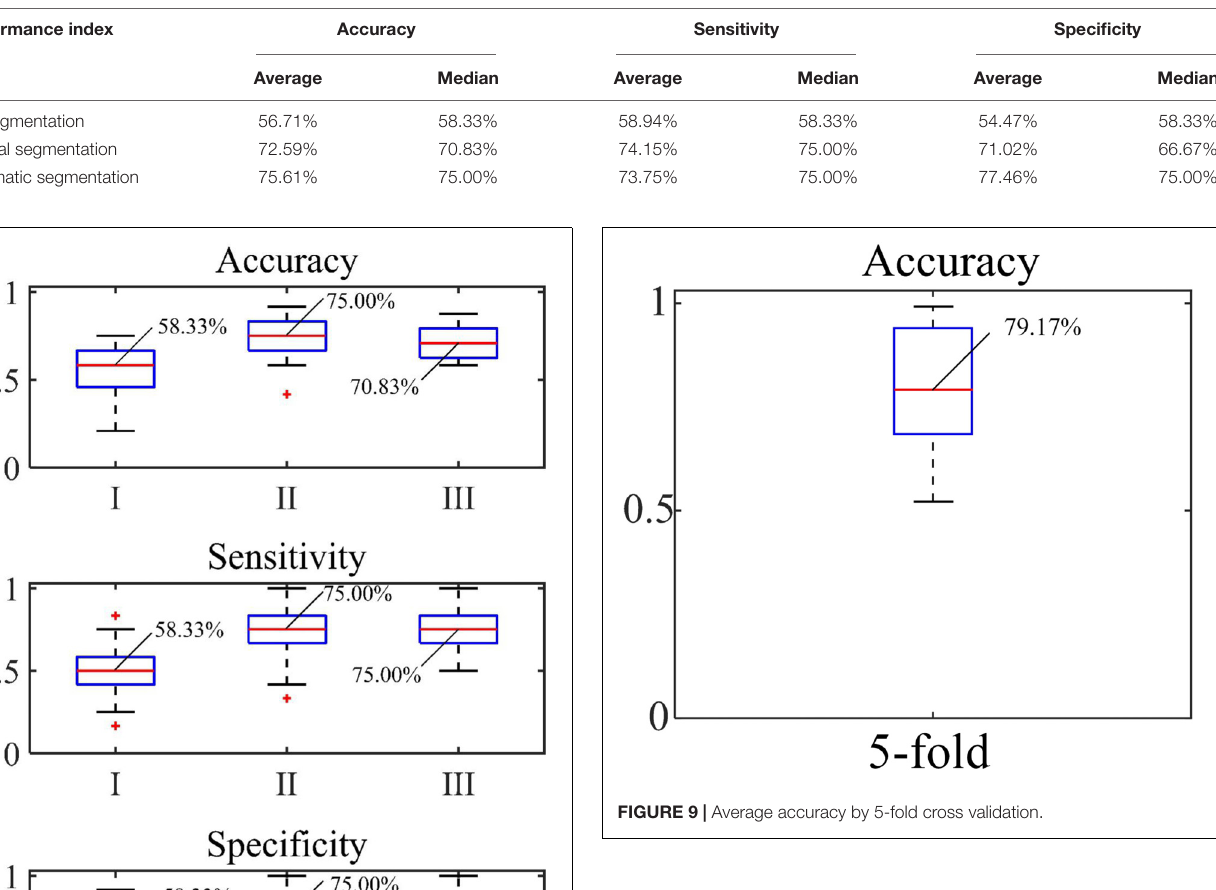
TABLE 3 | Quantitative statistics of classification performance after three segmentation processes.